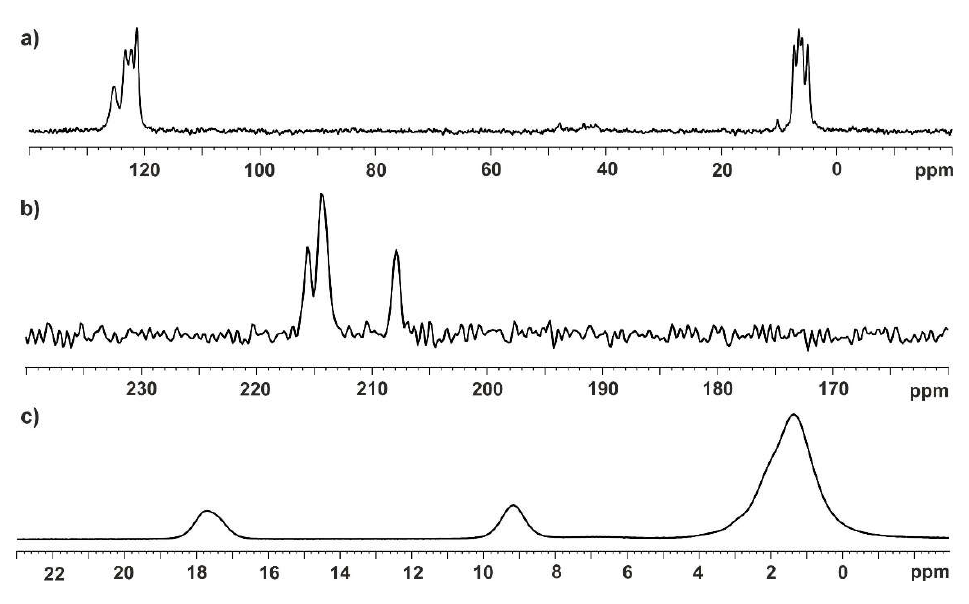
Figure 2. ( a ) 13 C CP/MAS spectrum recorded with a spinning rate of 8 kHz; ( b ) 15 N CP/MAS spectrum recorded with a spinning rate of 8 kHz; ( c ) 1 H VF/MAS NMR spectrum recorded with a spinning rate of 60 kHz.